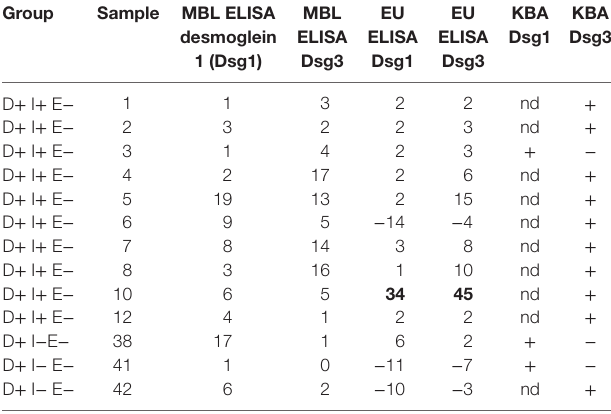
Values are expressed in U/mL. Positive results are in